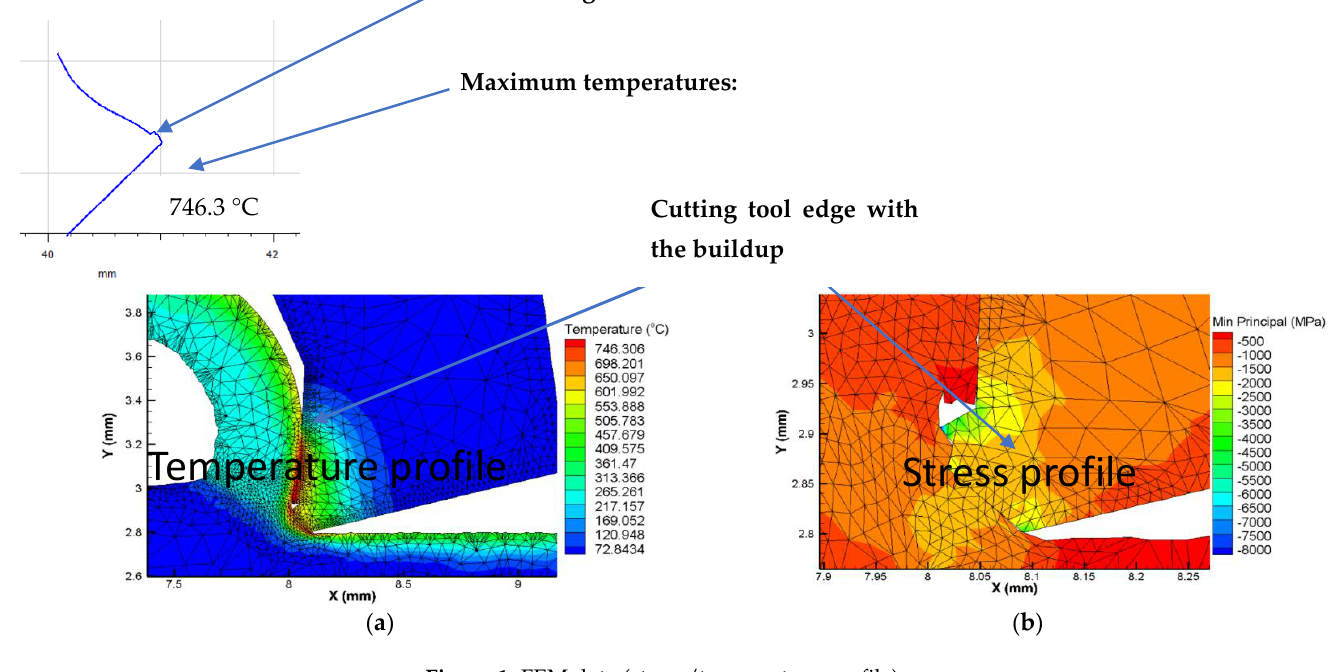
Figure 1. FEM data (stress/temperature profile).